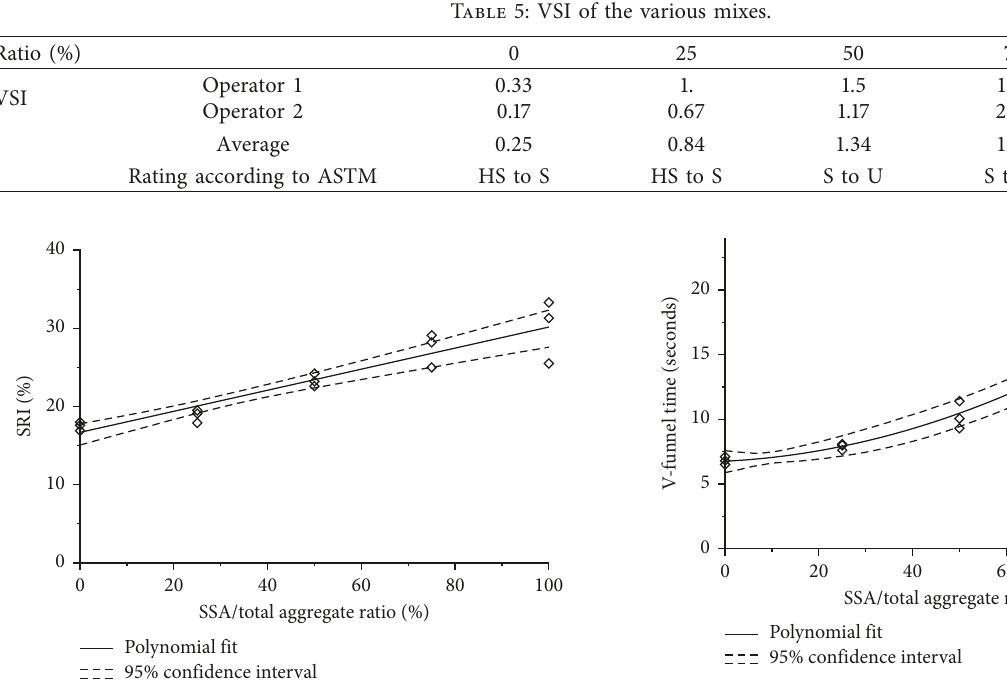
Figure 5: Relationship between the SSA replacement ratio and the V-funnel